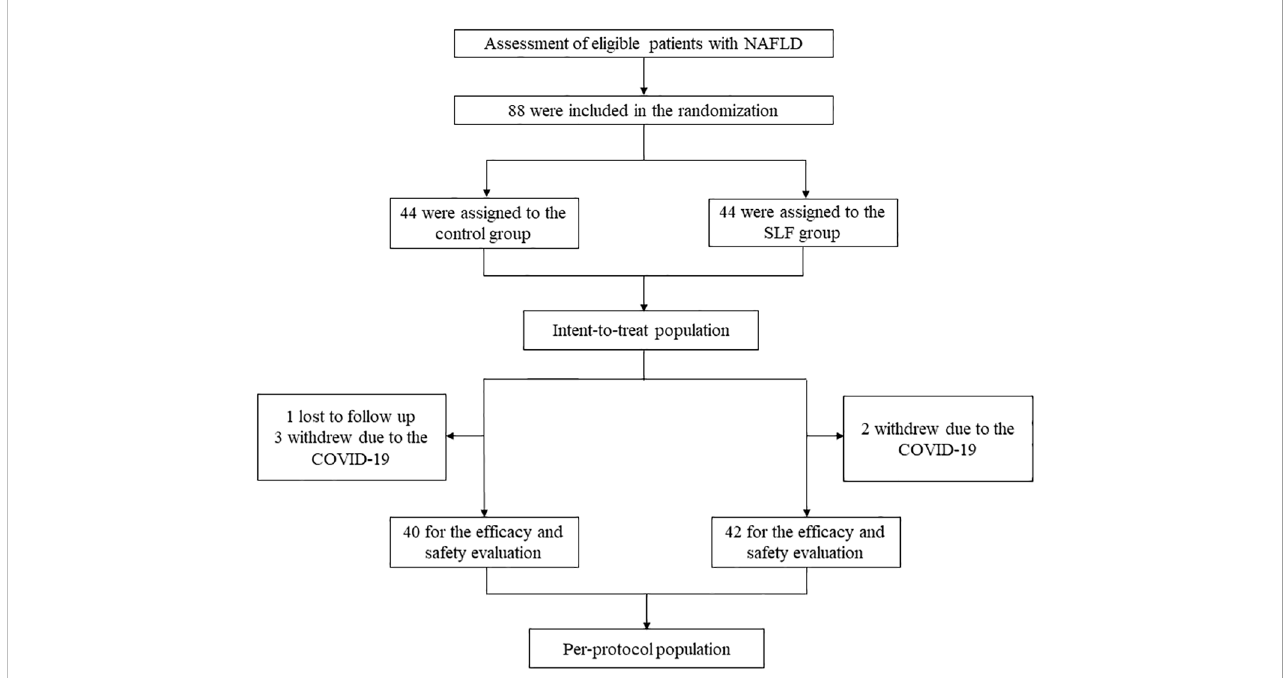
FIGURE 1 Flow chart of the study. A total of 88 NAFLD patients who were assessed to be eligible were made up of the intent-to-treat population. These patients were randomly divided into the control group and the SLF group, and 1 patient was lost to follow up and 3 patients withdrew due to COVID-19 in the control group, whereas 2 patients in the SLF group. The remaining 82 patients made up the per-protocol